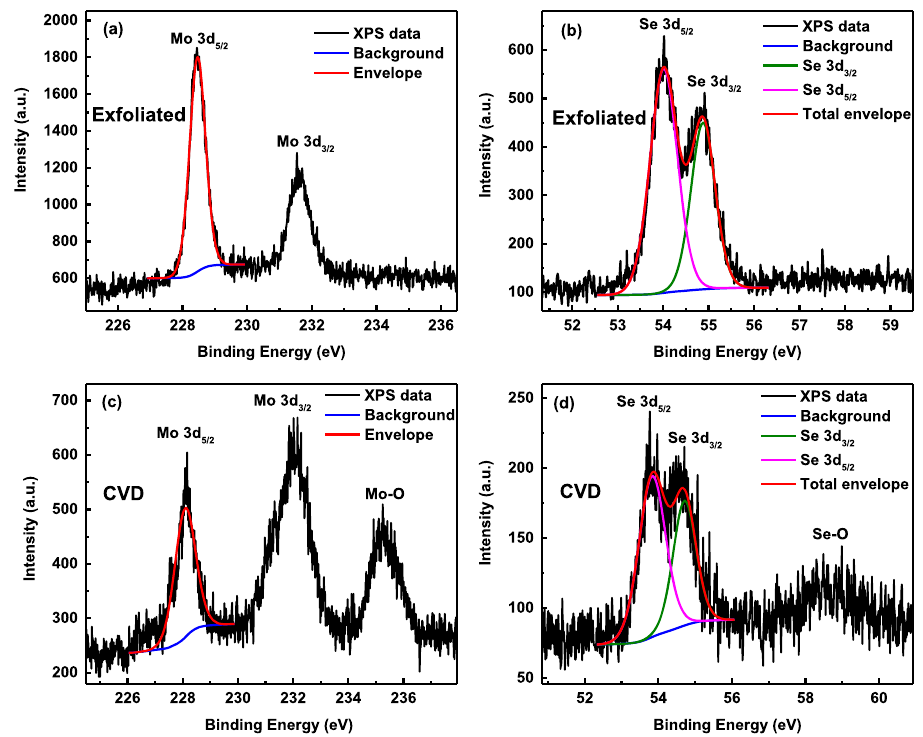
Fig. 6 X-ray Photoelectron Spectroscopy results of the exfoliated multilayer and CVD monolayer MoSe 2 samples: a and c are the Mo 3d peaks in exfoliated and CVD samples, respectively; b and d are the Se 3d peaks in exfoliated and CVD samples,